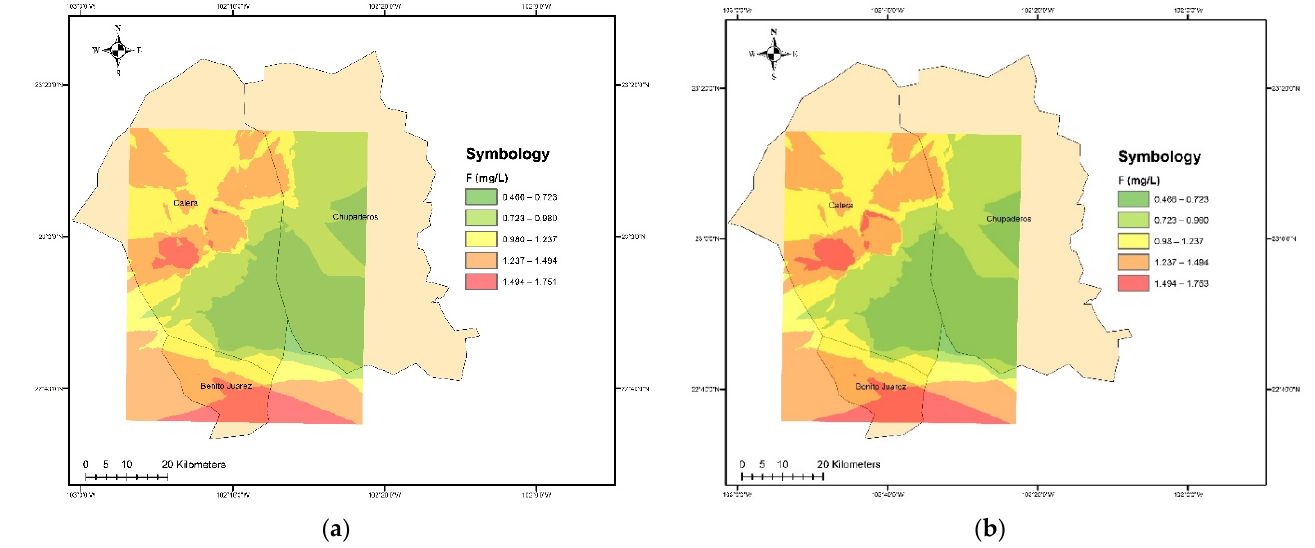
Figure 7. Fluorine concentration in groundwater of the study area: ( a ) 2015; ( b ) 2020.